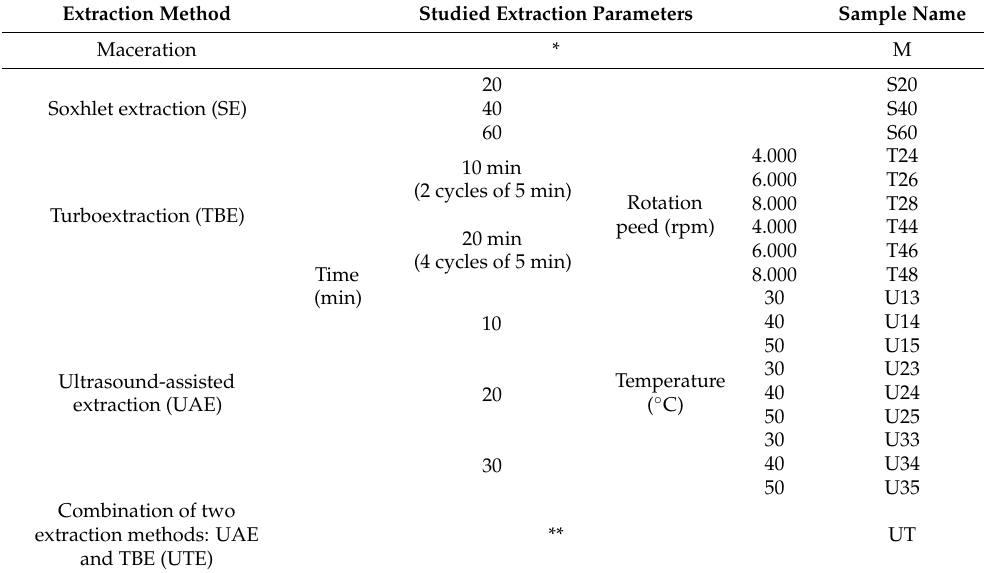
Table 1. Nomenclature of the obtained extract samples of the study.